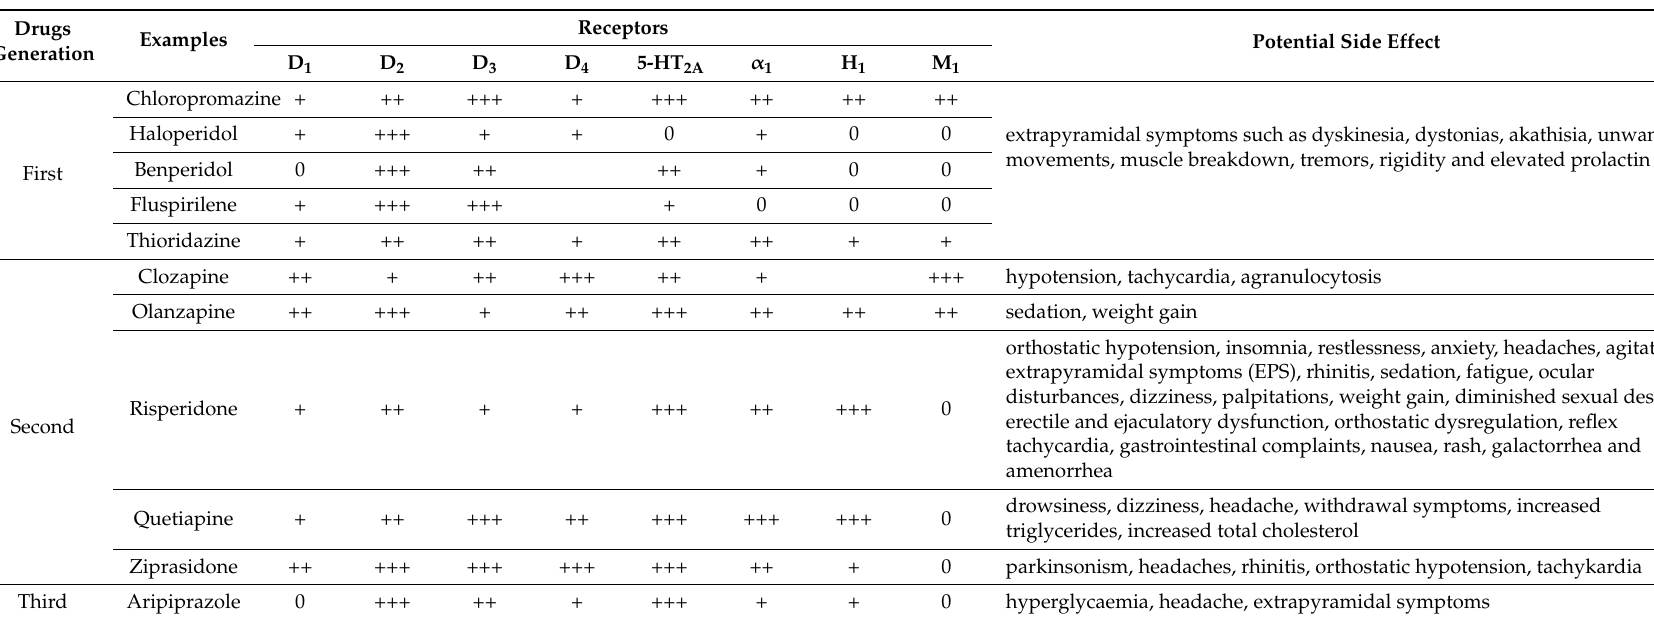
Table 2. Relative neurotransmitter receptor affinities for first, second and third generation antipsychotics and involved side